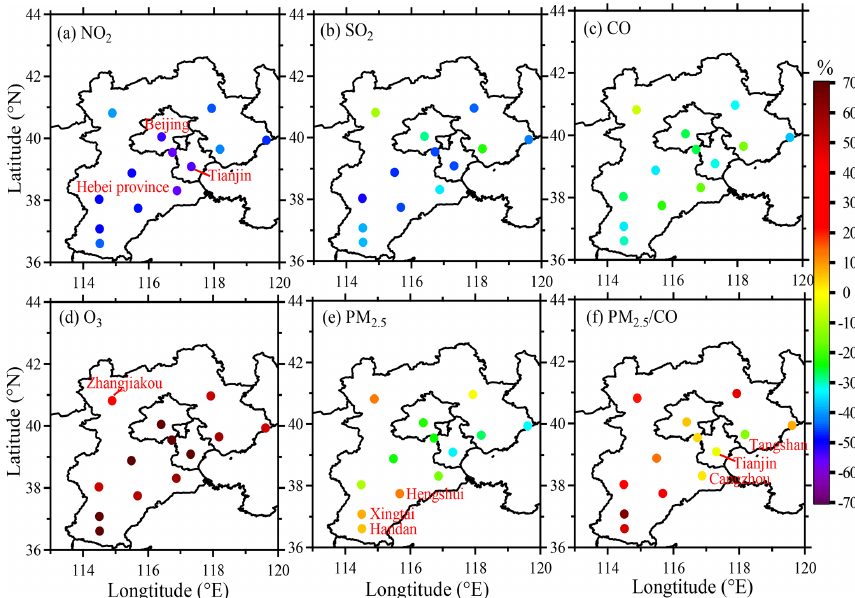
Figure 7. Percent changes in trace gas volume mixing ratios (NO 2 , SO 2 , CO, and O 3 ), the PM 2 . 5 mass concentration, and the PM 2 . 5 / CO ratio during the BG period relative to the POL period: 100 ×